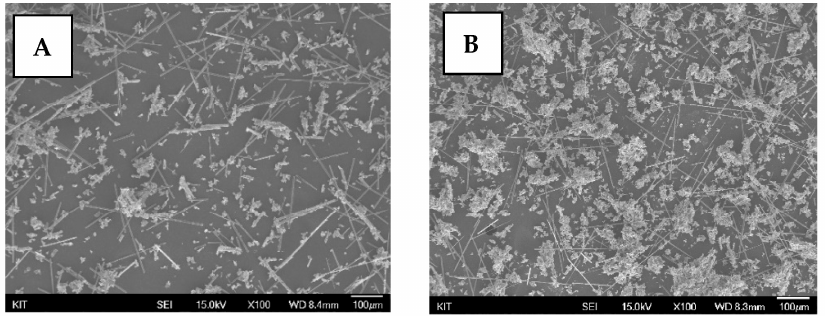
Figure 4. SEM images showing the length variation of NiCF in the ( A ) MF-NiCF/PA6 and ( B ) SF-NiCF/PA6 composites.